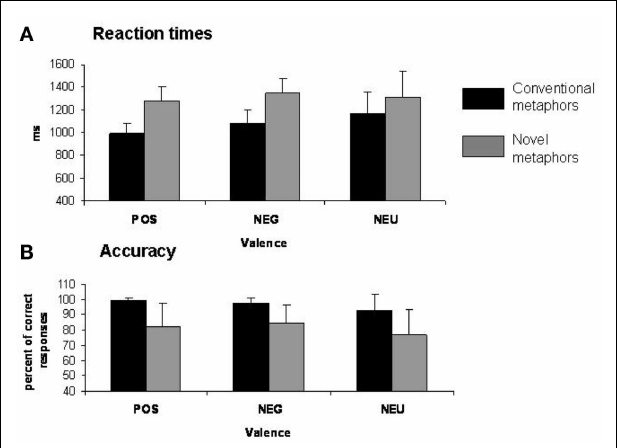
FIGURE 1 | Behavioral results . (A) Mean reaction times (SE) for each condition. (B) Percent of correct responses (SE) for each condition.